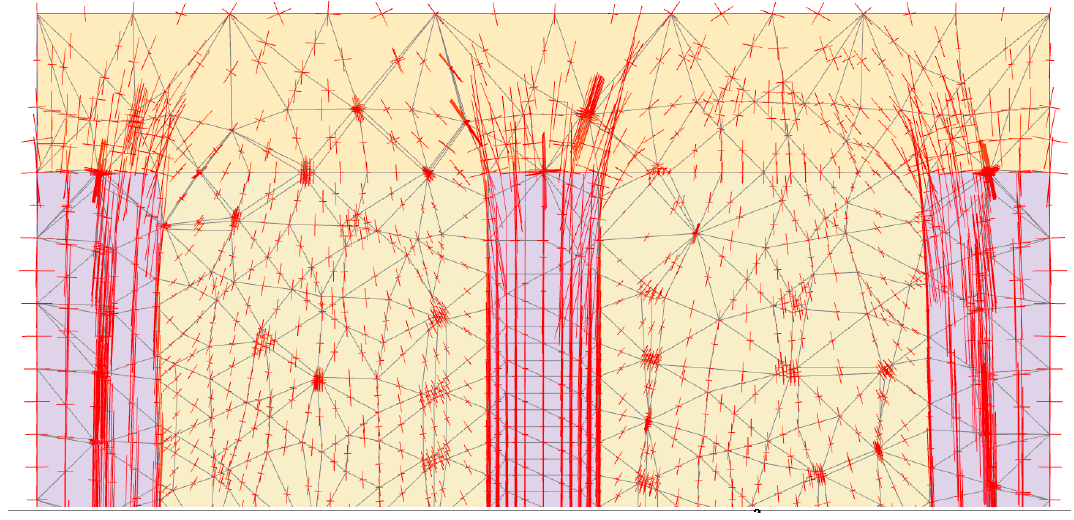
Figure 12. Principal stress